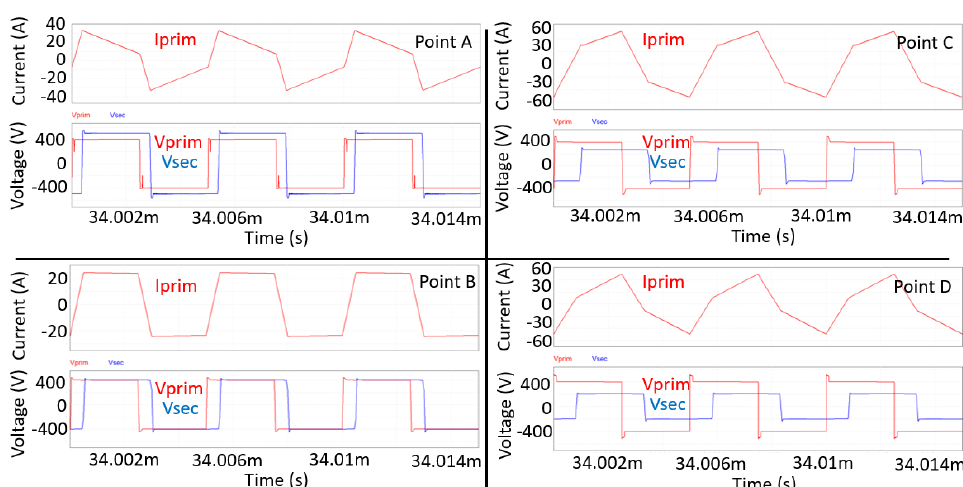
Figure 8. DAB converter V out vs. I out chart.